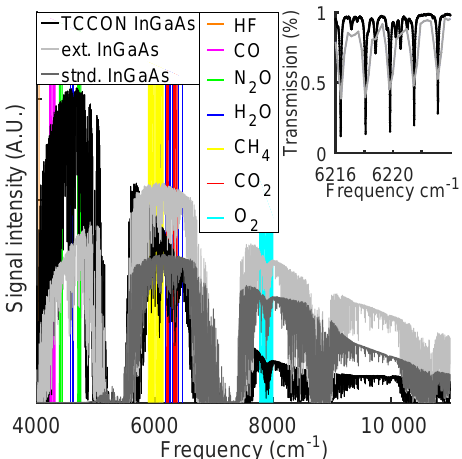
Figure 1. Example of scaled spectra from three different detector types, with retrieval windows highlighted. The spectrum from the EM27/SUN extended InGaAs detector was scaled 10 times more than the spectrum from the standard InGaAs